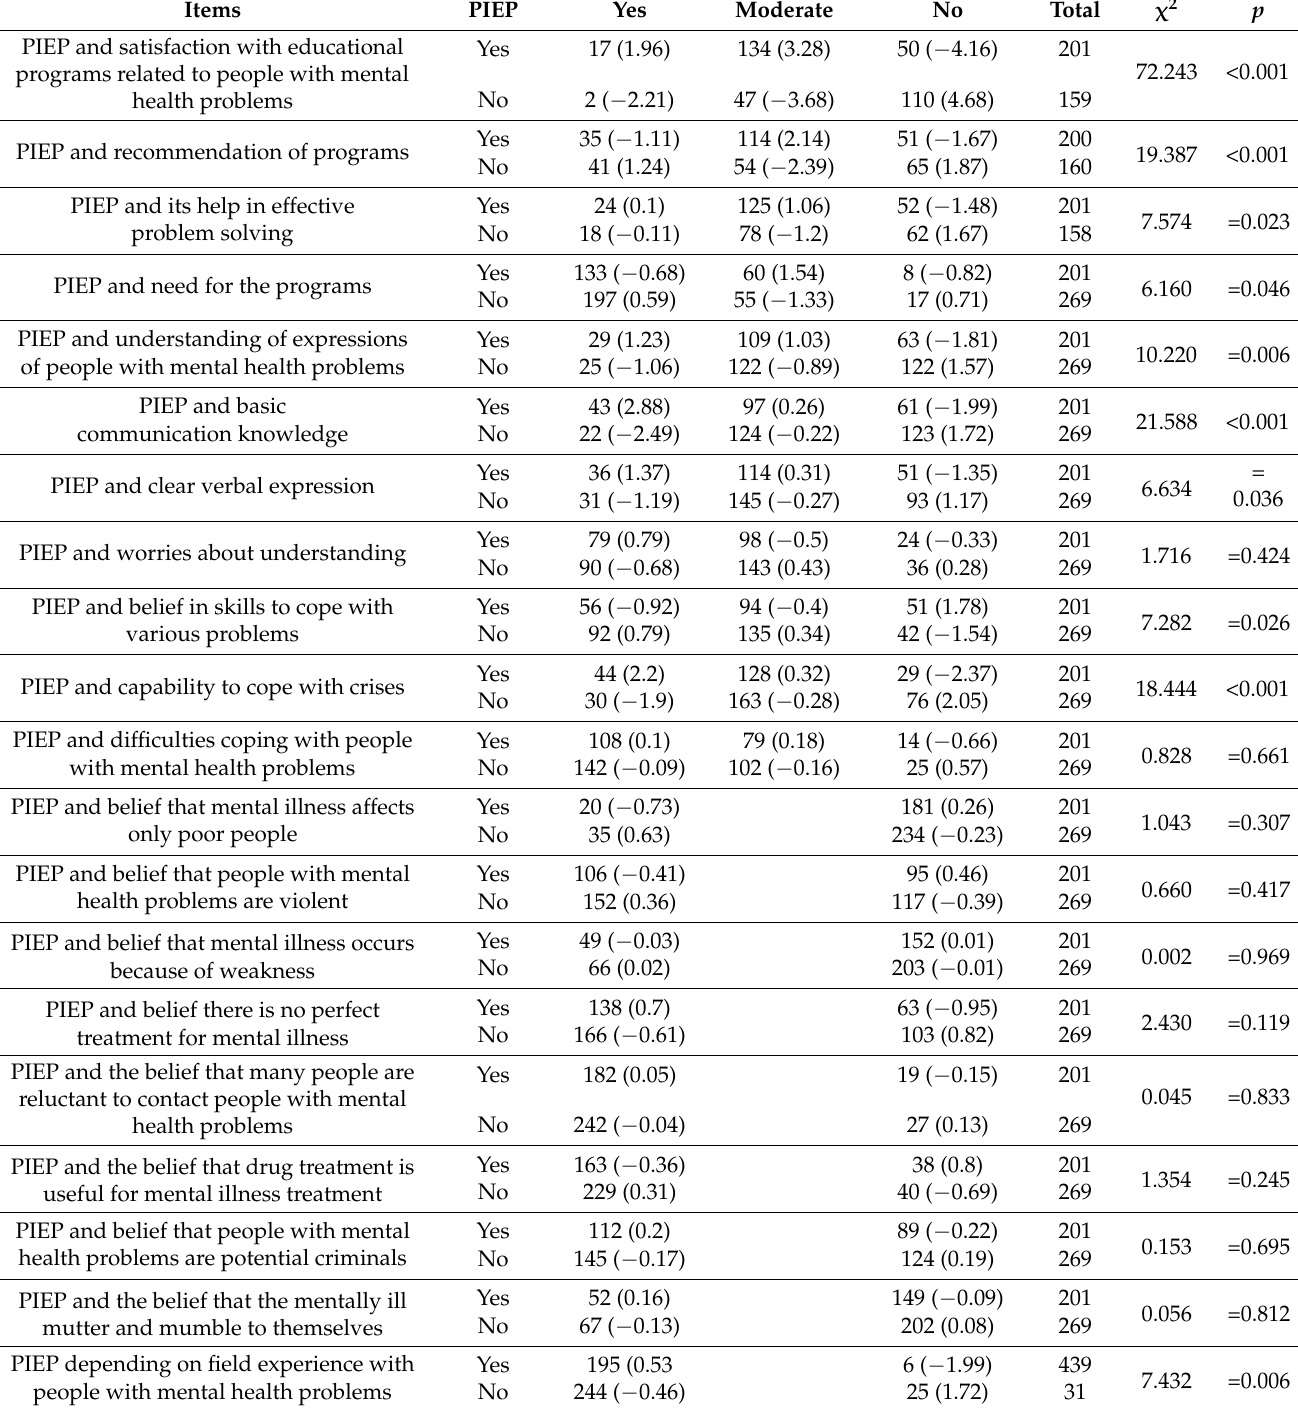
Table 2. Attitudes of police officers toward people with mental health problems depending on participation of the former in educational programs (frequencies and standardized